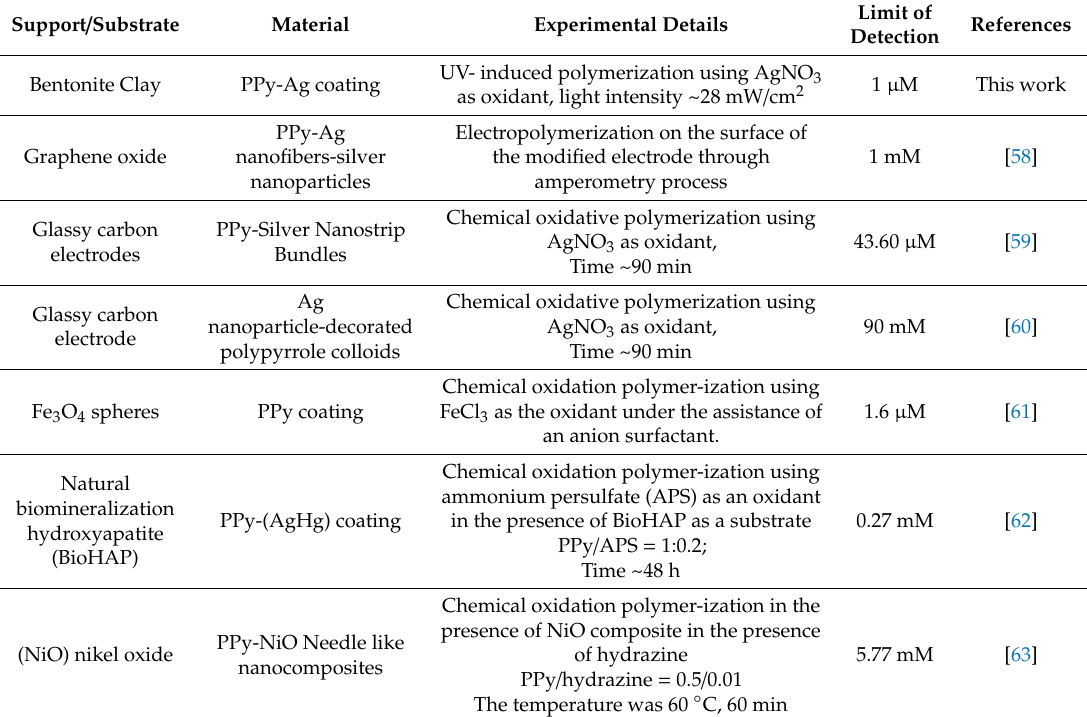
Table 2. Summary of the polypyrrole-based composites on various kinds of supports for H 2 O 2